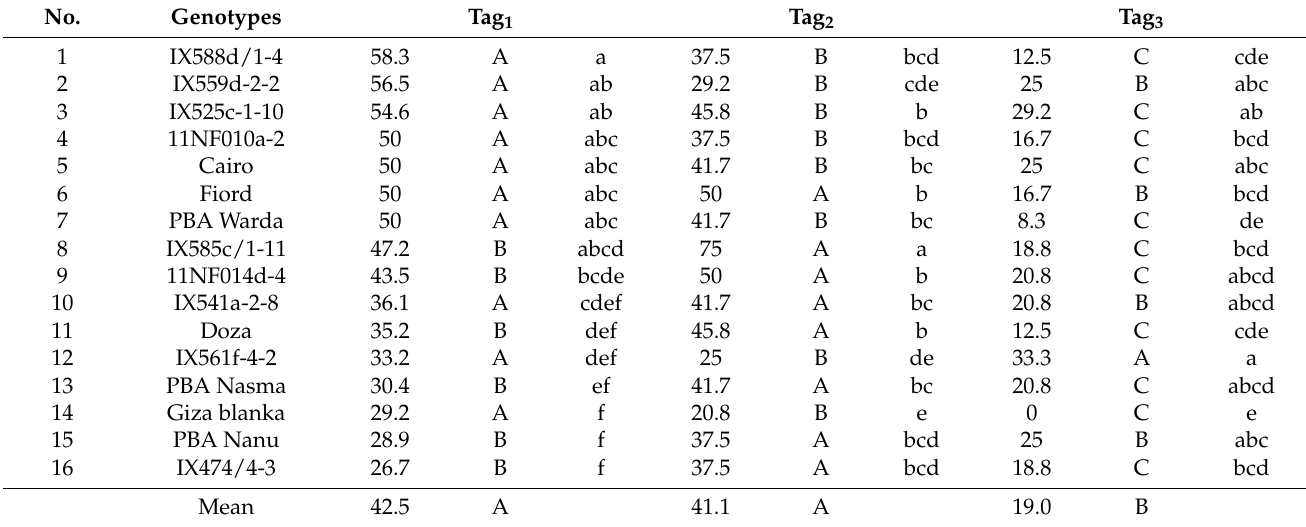
Table 2. Percentage of flowers converted to pods at three stages of faba ban (Tag 1 , Tag 2 and Tag 3 ) in 2016/2017 at the Agricultural Research Station at Dirab ( n = 3). Means denoted by different capital letters are significantly different according to time of tagging (l.s.d. = 6.1 ***), and small letters denote genotypes within each time of tagging (l.s.d. = 14.1 *). No.